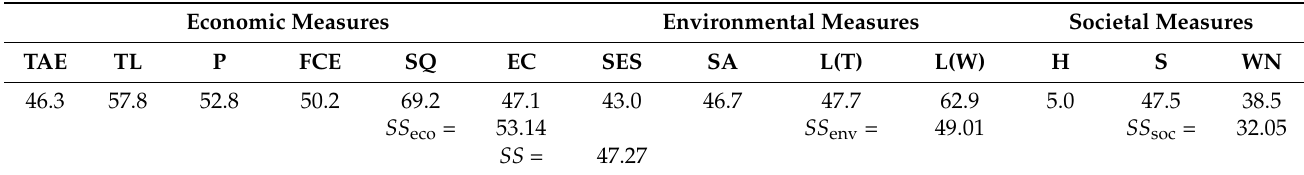
Table 4. The SS Results of the Example Related to the Turning